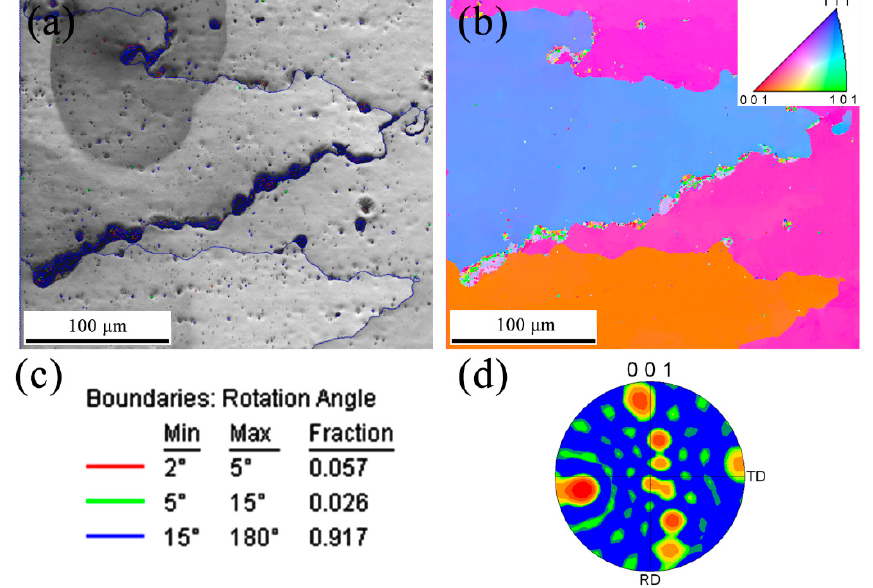
Figure 12. EBSD scans of the crack at the top region of AF sample, ( a ) grain boundaries colored to show different angles, ( b ) IPF image, ( c ) the color legend of grain boundaries, and ( d ) [001] pore figure of the specimen.